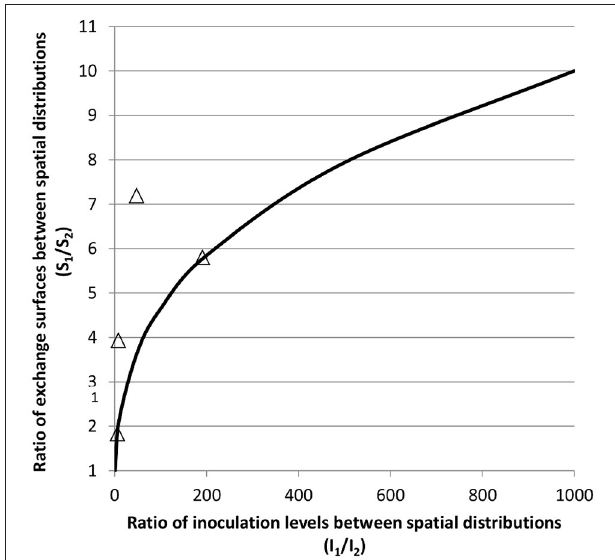
FIGURE 12 | Theoretical relation (black line) for two different spatial distributions, 1 and 2, between the ratio of the exchange surfaces (S 1 /S 2 ) and the ratio of inoculation levels (I 1 /I 2 ); ( △ ) experimental data either manually measured or obtained from image analysis of confocal microscopy images from Jeanson et al. (2011) and from Le Boucher et al. (2013)